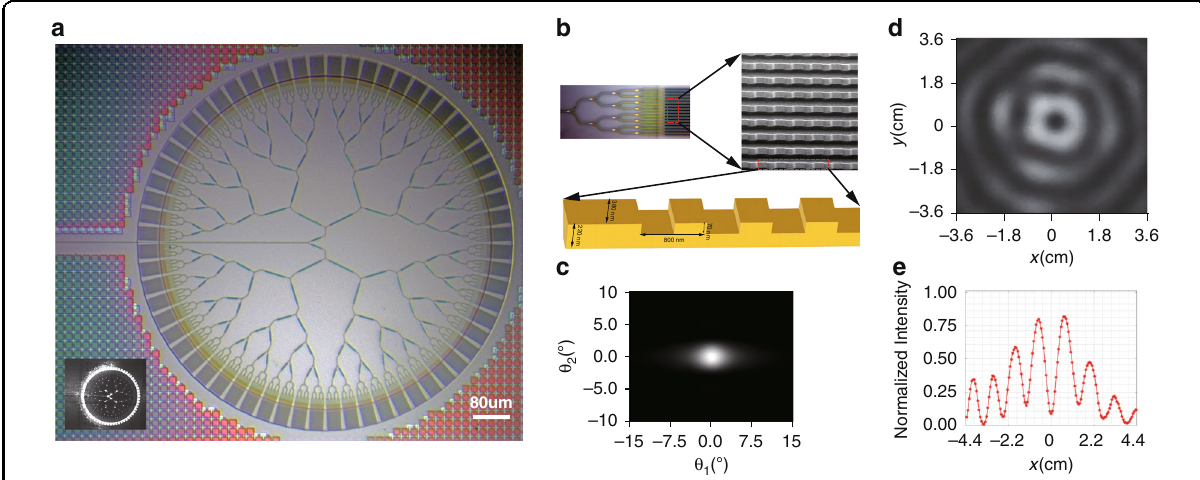
Fig. 1 On-chip Bessel – Gaussian beam generator. a Optical microscope image for an integrated photonic chip used as a Bessel – Gaussian beam generator. The inset is a surface image captured when the laser light emitted from the chip. b Enlarged view of local grating arrays in the photonic chip and Scanning electron microscope (SEM) image of the grating arrays. c Simulated intensity distribution of far- fi eld from the grating arrays. d Experimentally measured BGb pro fi le at 5.91 m. e One-dimensional intensity distribution of light fi eld at 5.91